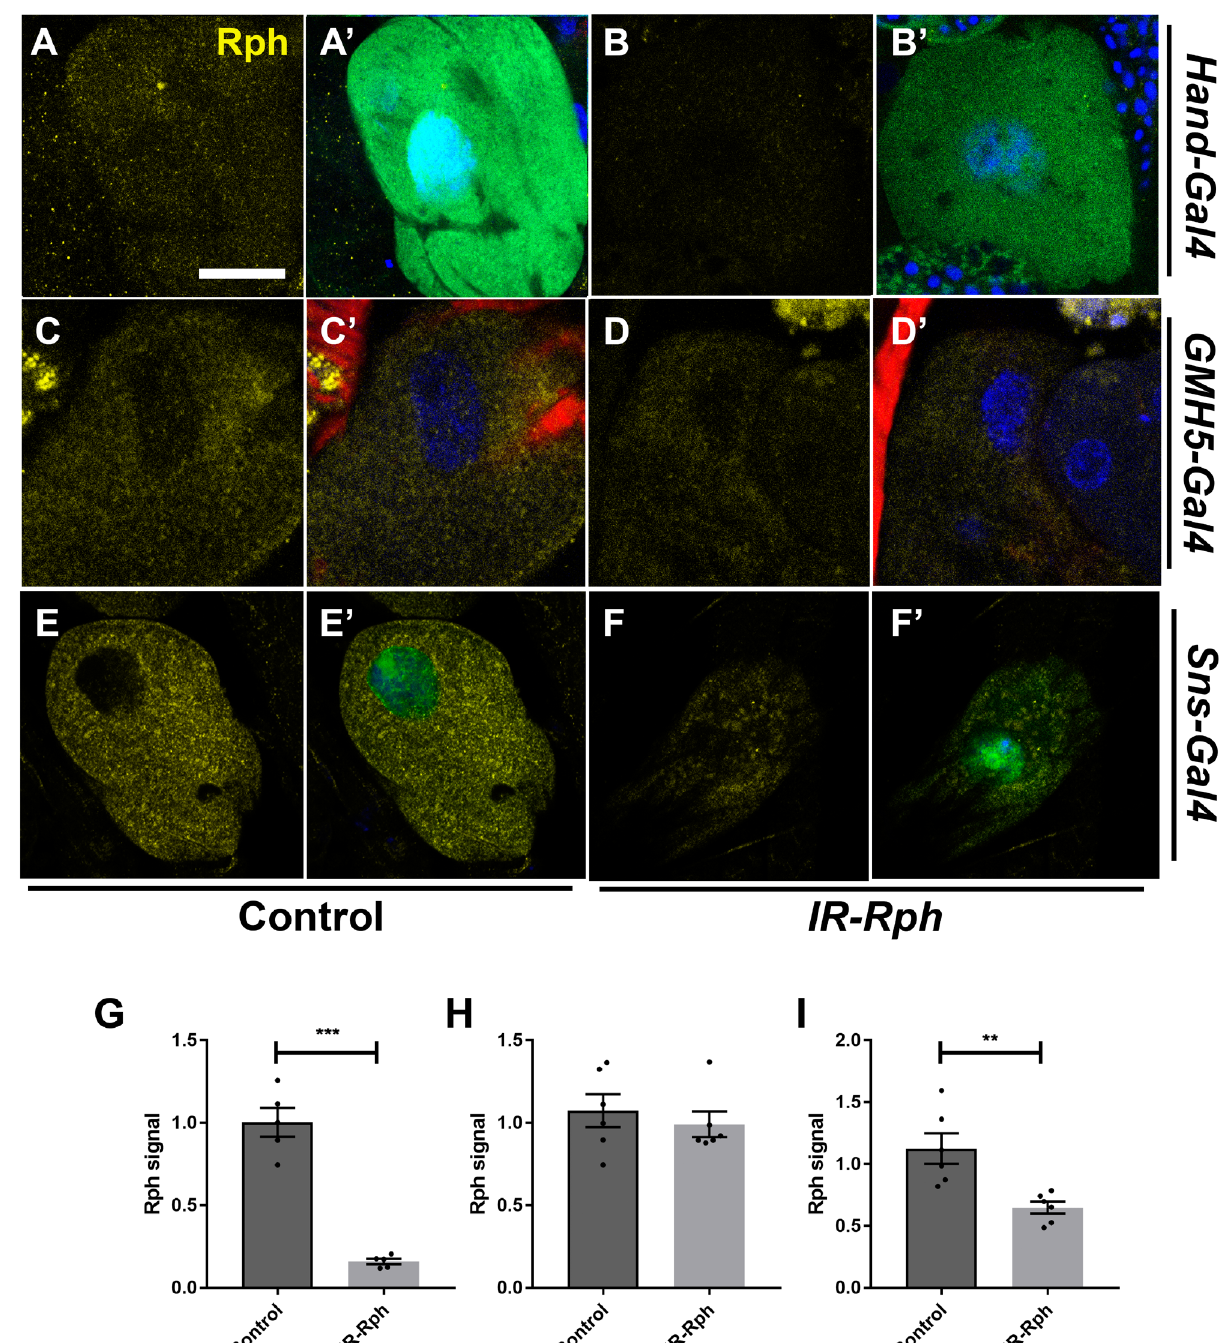
Figure 2. Rabphilin is expressed in adult Drosophila nephrocytes. Representative confocal images of adult control ( A, A ′ , C, C ′ , E, E ; Hand-Gal4 UAS-GFP > yw , GMH5-Gal4 UAS-GFP > yw and Sns-Gal4 > yw , respectively) and flies expressing UAS-IR-Rabphilin line 1 ( IR-Rph , B, B ′ , D, D ′ , F, F ′ ) under the control of the Hand-Gal4 ( A, A ′ , B, B ′ ), GMH5-Gal4 ( C, C ′ , D, D ′ ) and Sns-Gal4 ( E, E ′ , F, F ′ ) driver. Immunostaining with the anti-Rabphilin antibody (in yellow) showed Rph presence in pericardial nephrocytes of all control flies. Rph relative signal from flies expressing IR-Rph line 1 construct under Hand-Gal4, GMH5-Gal4 and Sns-Gal4 are represented in G, H, I , respectively. Nuclei were counterstained with DAPI (blue) and phalloidin (red) was used to stain actin filaments of the Drosophila heart surrounding pericardial nephrocytes. Scale bar = 10 µm. Student’s t-test. ** p value < 0.01, *** p value <